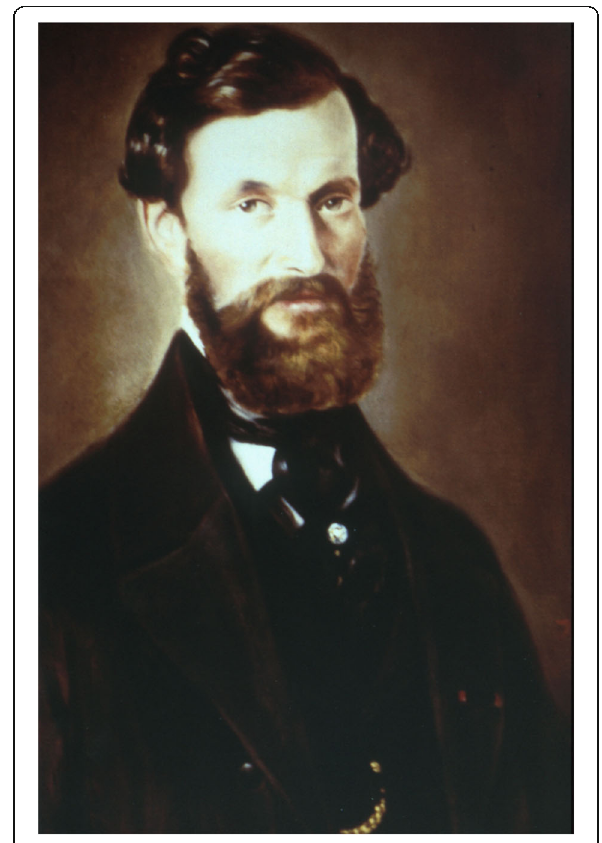
Fig. 1 Ludwig Wilhelm Mauthner von Mauthstein. Lithograph by Fig. 2 Franz von Rinecker (photograph of the Children ’ s